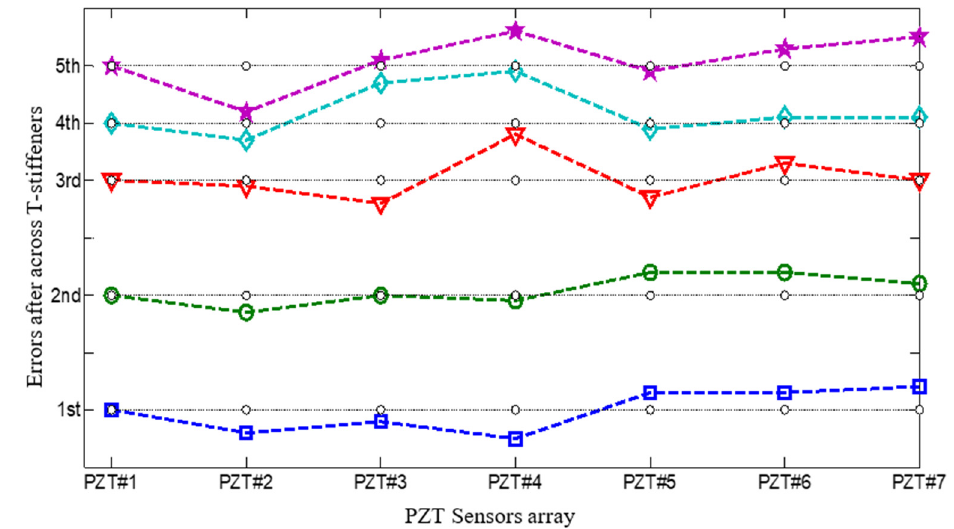
Figure 9. Phase errors when Lamb waves cross T-stiffeners.